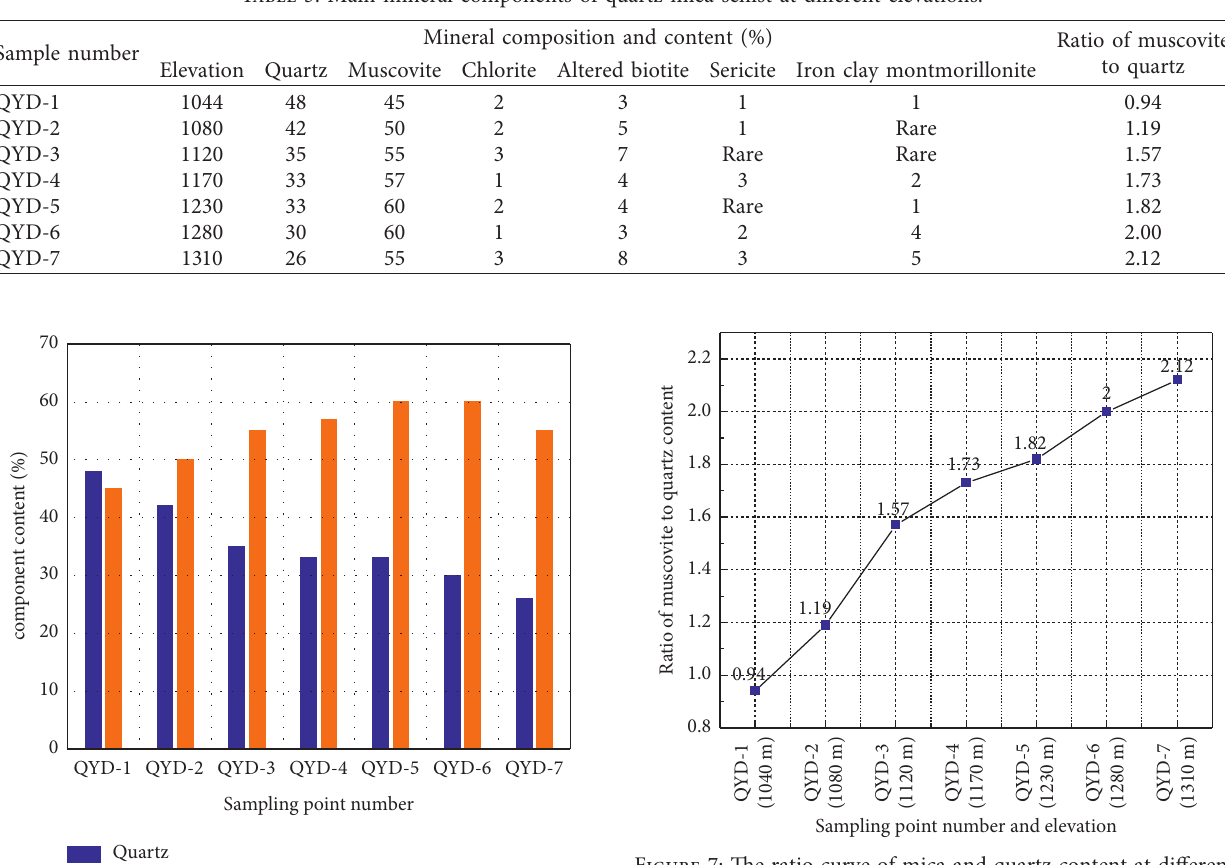
Figure 6: Quartz and mica content map at different elevation sampling points.